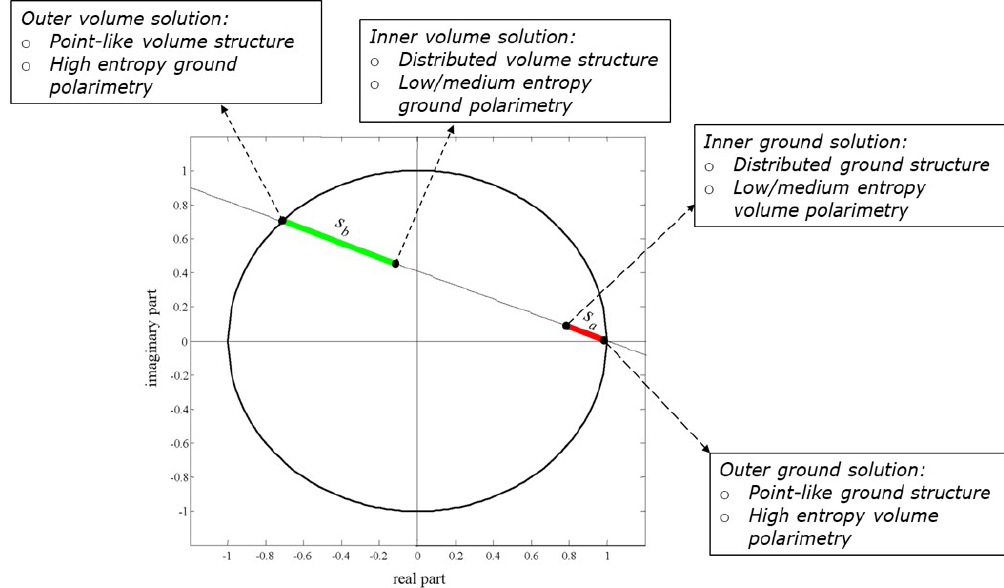
Figure 3. Geometrical representation of possible solutions for ground/volume scattering decomposition based on single-baseline polarimetric–interferometric techniques (PolInSAR) data. The red and green segments represent the range of permitted interferometric coherence of ground and volume scattering in the complex plane. The four solutions at either ends of each segment are referred to as outer or inner solutions for ground and volume